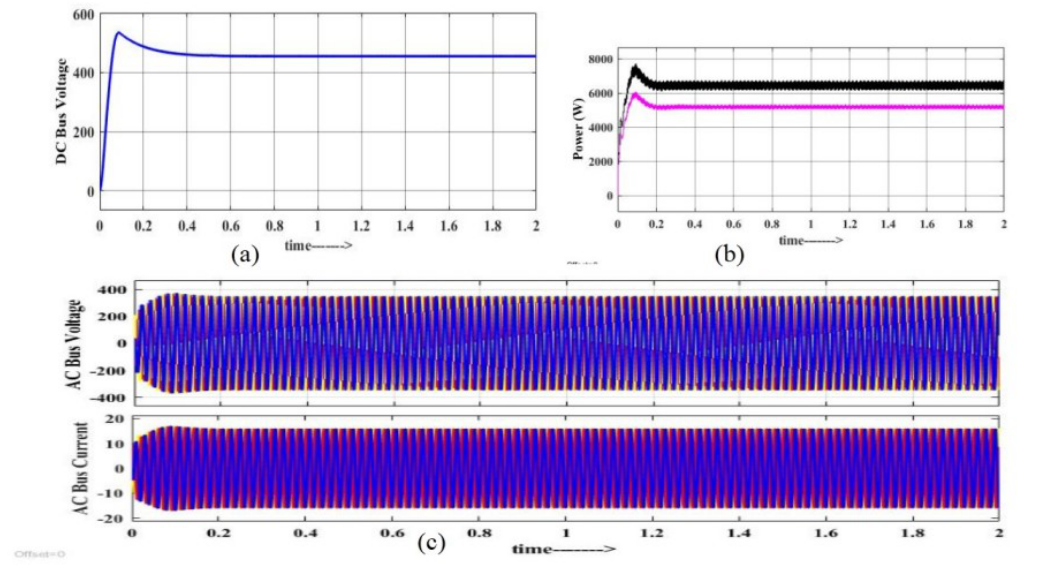
Fig. 7. System Parameters under islanded mode with Icos Φ controller: (a) DC bus voltage, (b) Power, (c) AC bus voltage and